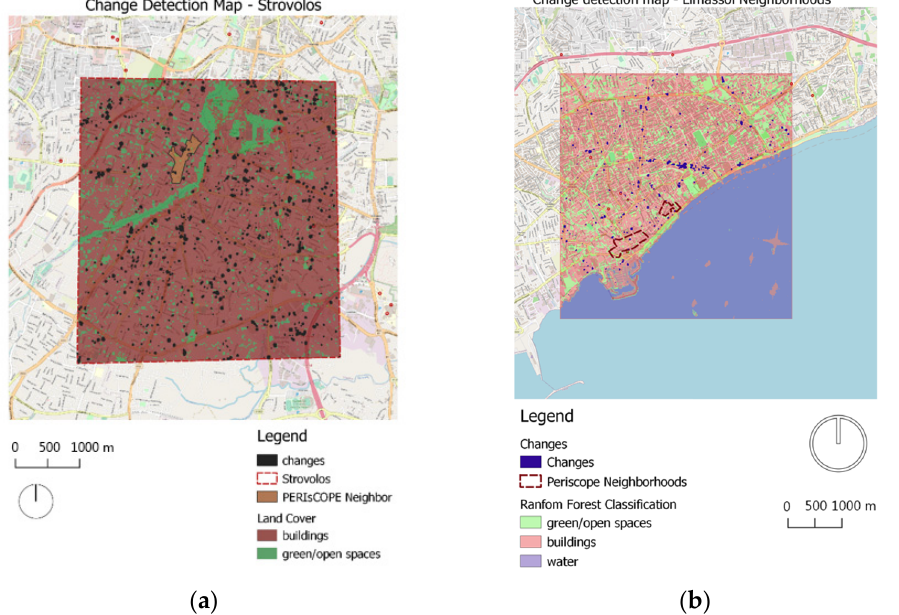
Figure 15. Focused analysis of the study areas by means of change detection maps of ( a ) Strovolos; ( b ) the Turkish-Cypriot quarter of Limassol.